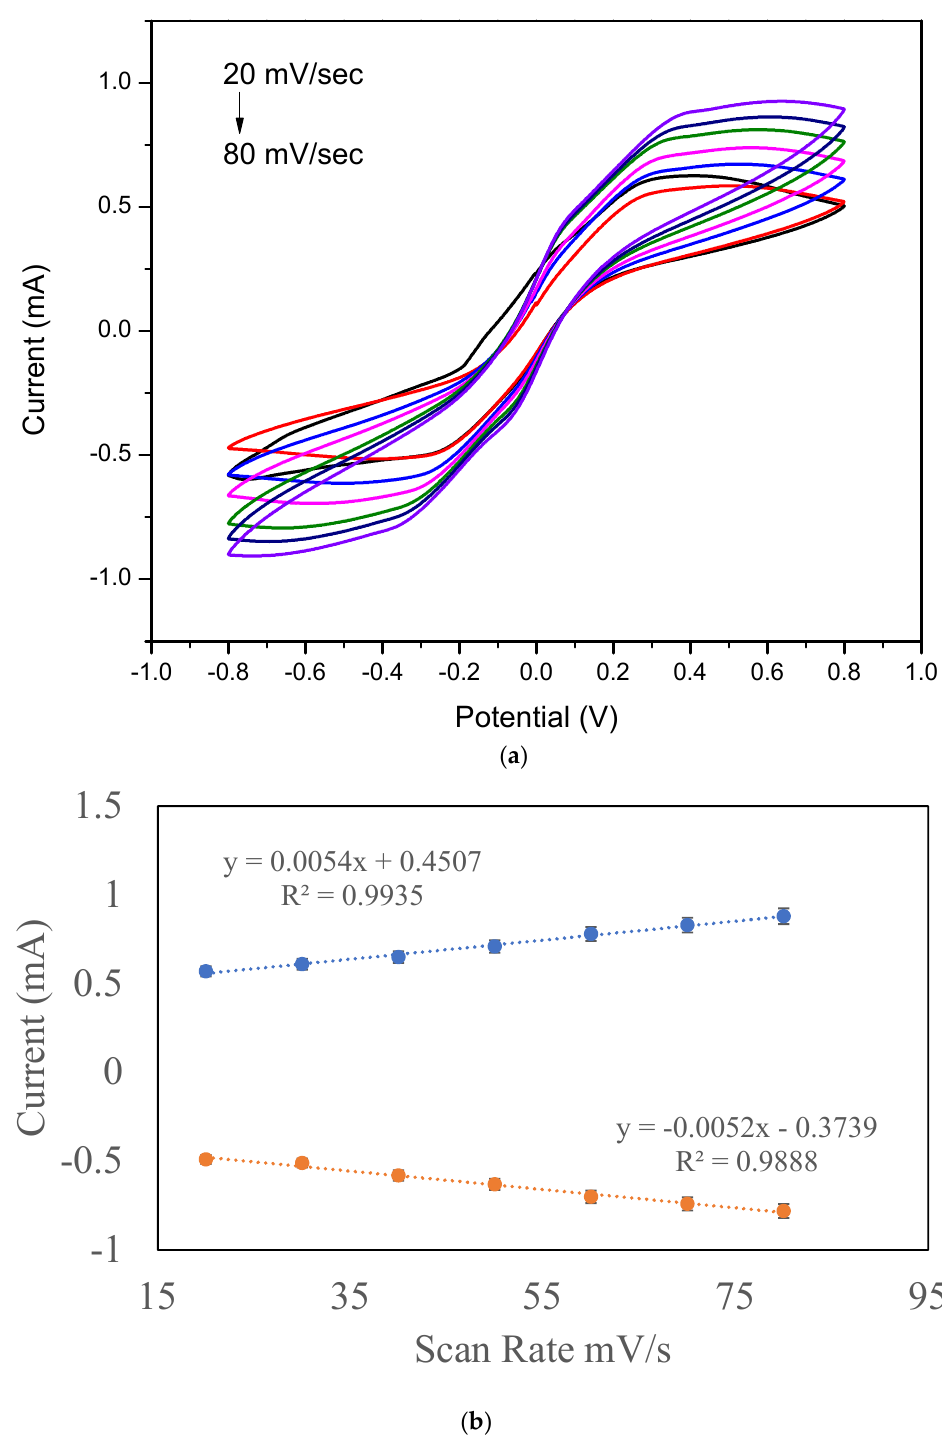
Figure 10. ( a ) CV recorded for MIP-CagA/Au/rGO@SPE at different scan rates in the presence of [Fe(CN) 6 ] 3 − /4 − electrolytes. ( b ) Representation of variations in the peak oxidation current (Ipa) and reduction peak current (Ipc) at different scan rates than the linear graph.